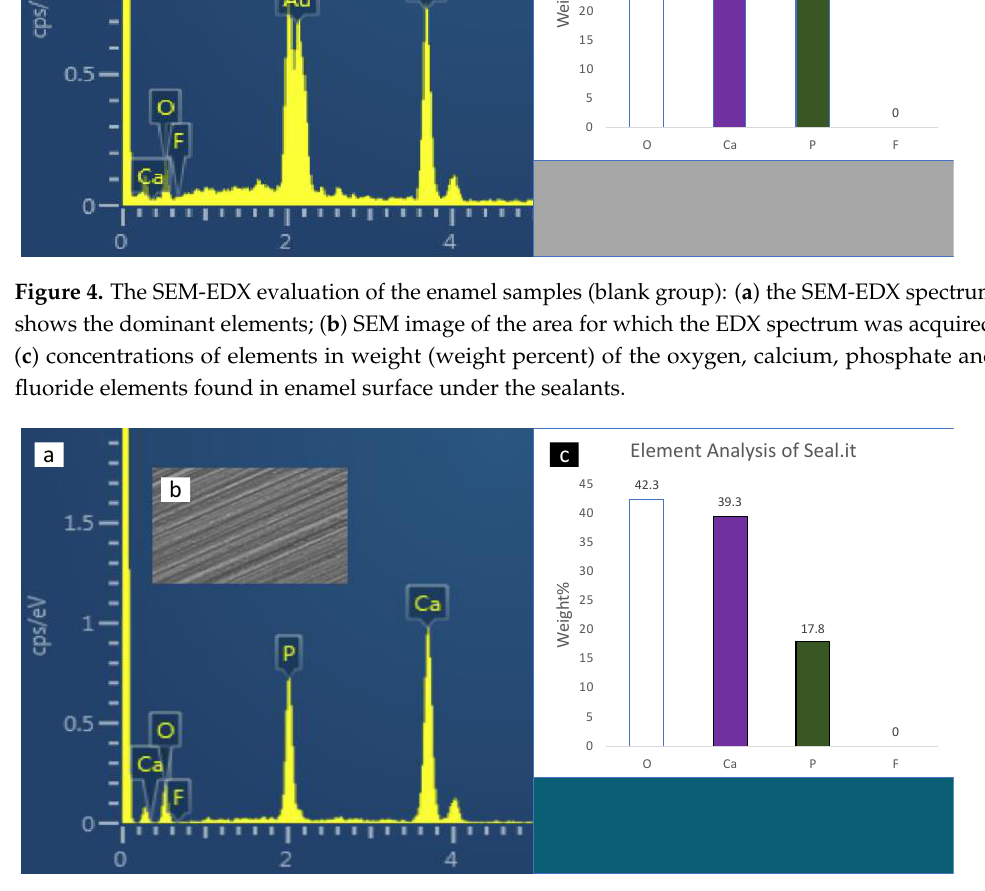
Figure 6. The SEM-EDX evaluation of the enamel samples under BioCoat: ( a ) the SEM-EDX spec- trum shows the dominant elements; ( b ) SEM image of the area for which the EDX spectrum was acquired; ( c ) concentrations of elements in weight (weight percent) of the oxygen, calcium, phos- phate and fluoride elements found in enamel surface under the sealants. Figure 7. The SEM-EDX evaluation of the enamel samples under ACTIVA KIDS: ( a ) the SEM-EDX spectrum shows the dominant elements; ( b ) SEM image of the area for which the EDX spectrum